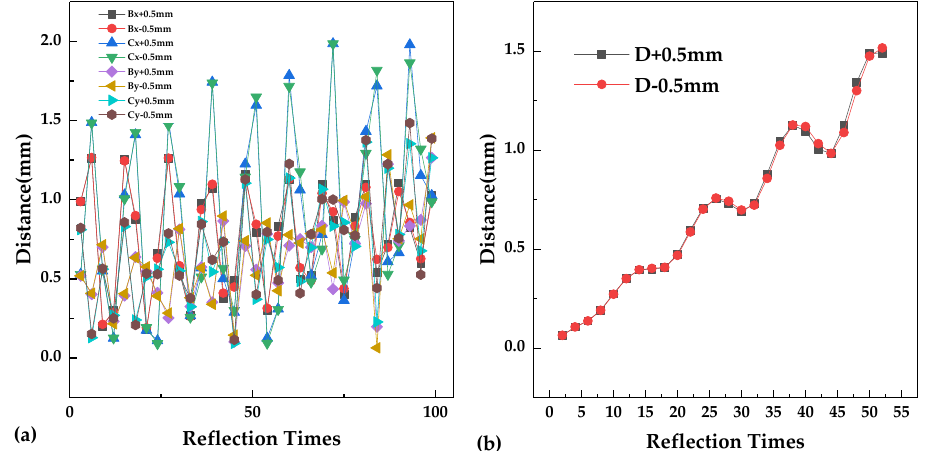
Figure 5. ( a ) Relation between the shift distance of the exit spot on mirror A and the reflection times before and after changes added to B x , B y , C x , C y for the three mirror-based gas cell. ( b ) Relation between the shift distance of the exit spot on mirror A and the reflection times before and after changes added to D for the two mirror-based gas cell.